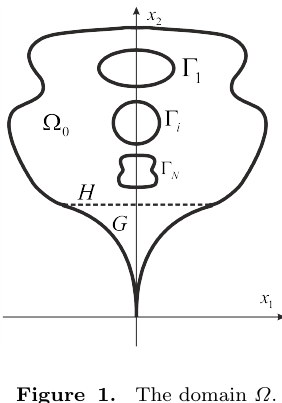
Figure 1. The domain Ω